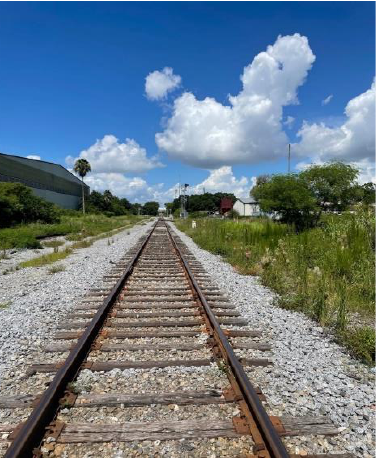
Figure 7. Challenges accessing reliable public transportation.